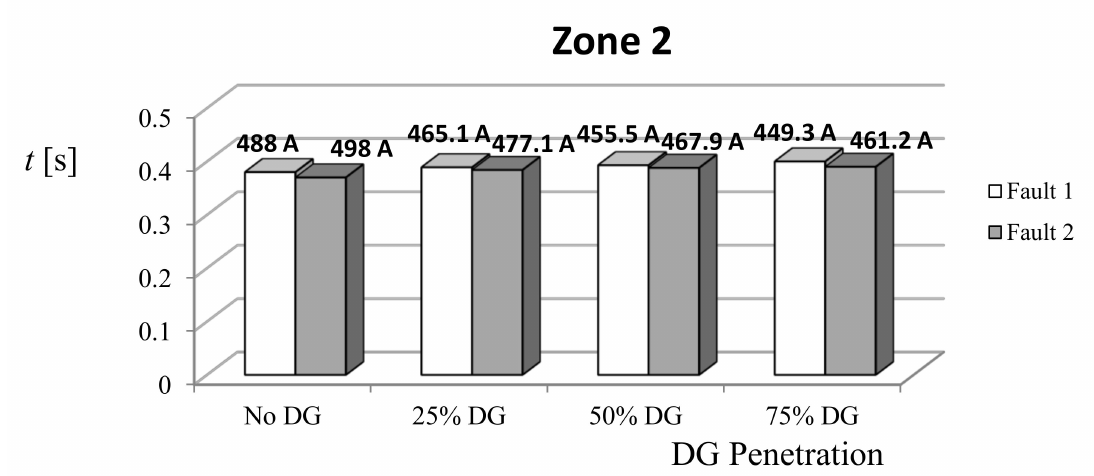
Figure 9. Triggering time, t , of the main feeder protection relay R632 in Protection Zone 2 (see Figures 2 and 6) for fault F1 downstream from the DG and fault F2 upstream from the DG, in relation to DG power supply. The currents detected by the relay when triggering were added to the graph in each